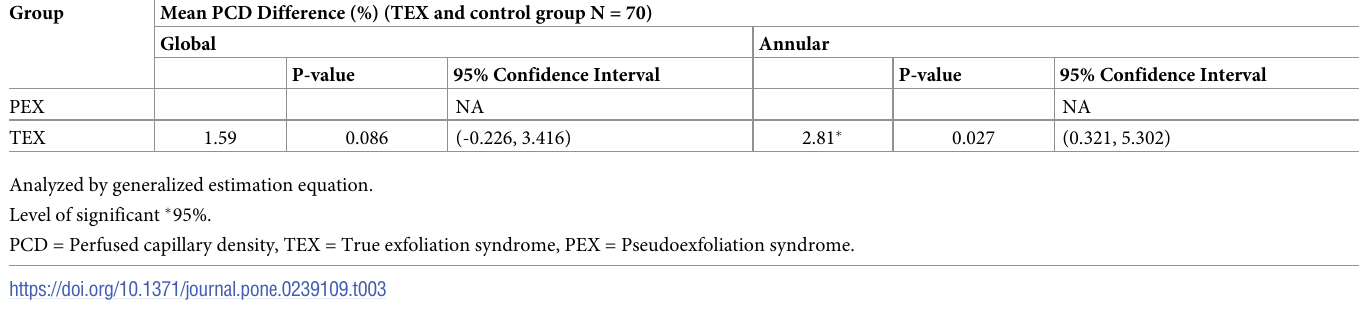
Table 3. Differences in globular, annular PCD between TEX and PEX. Group Mean PCD Difference (%) (TEX and control group N = 70)